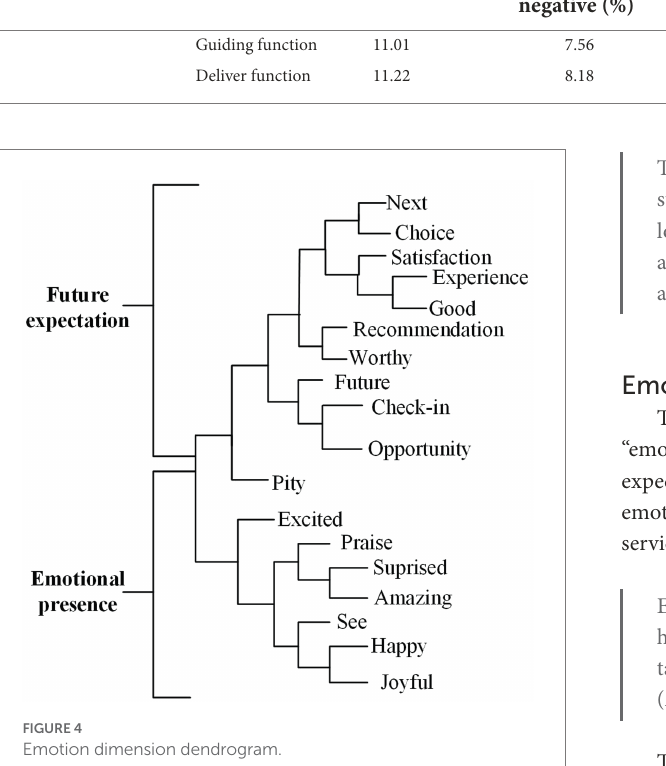
FIGURE 4 Emotion dimension